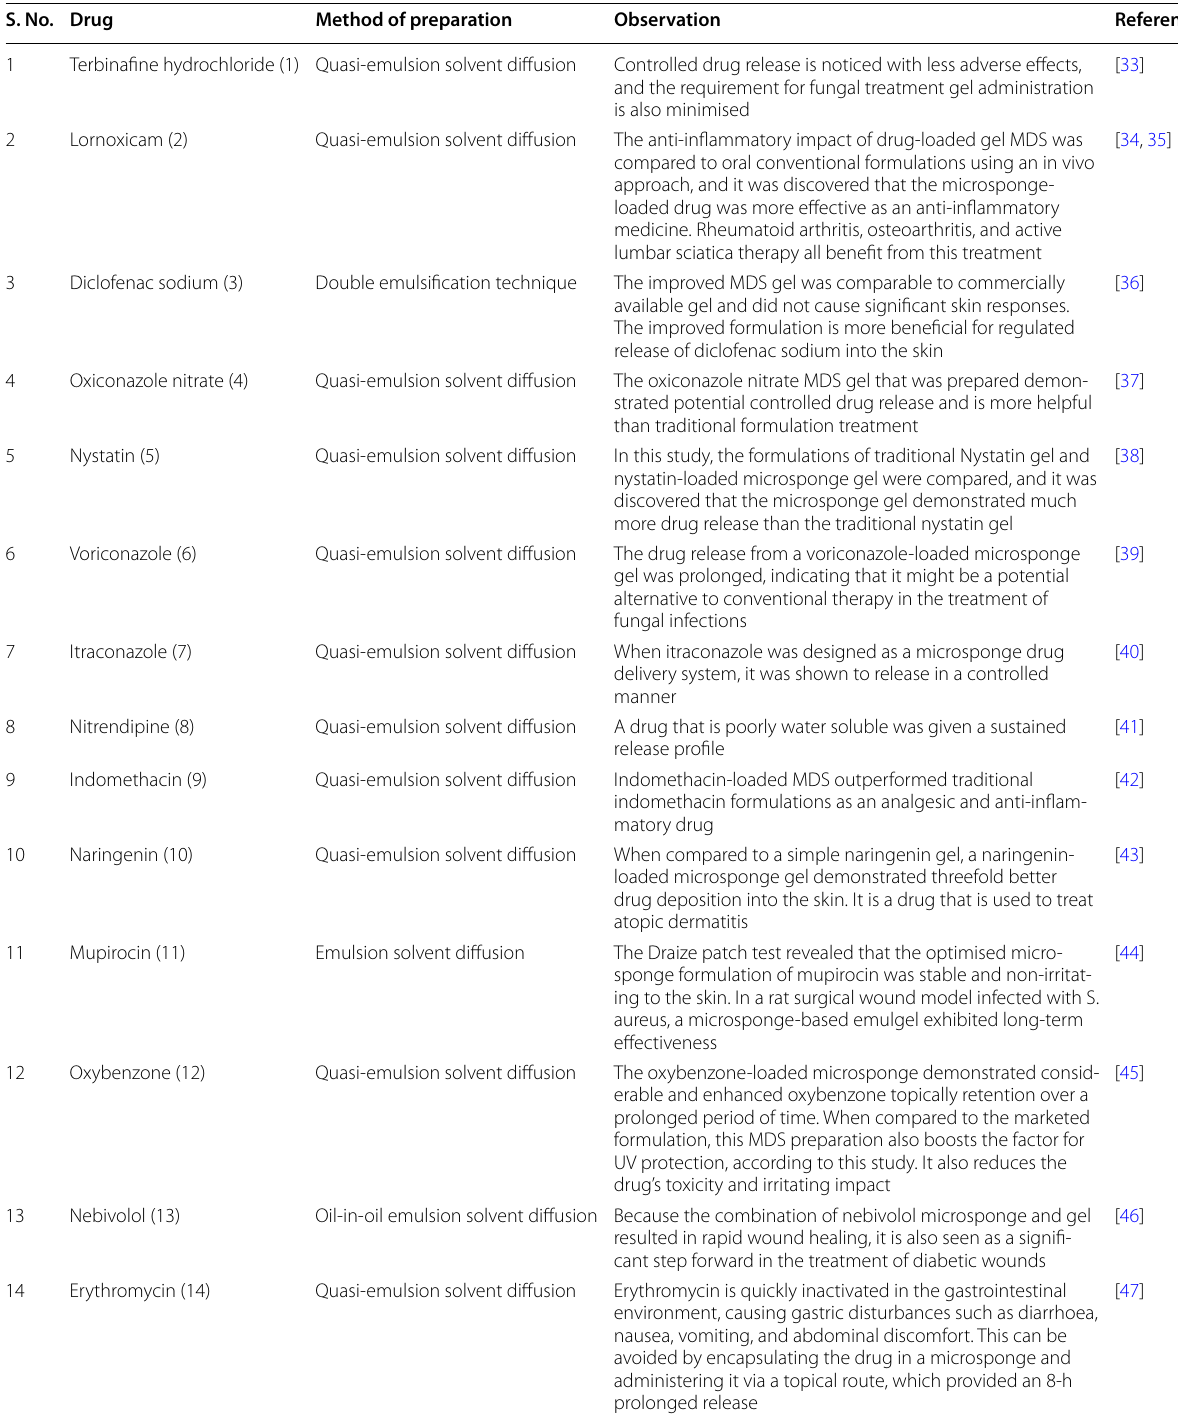
Table 5 List of research work that was conducted on MDS for topical administration of drugs S. No. Drug Method of preparation Observation Terbinafine hydrochloride (1) Quasi-emulsion solvent